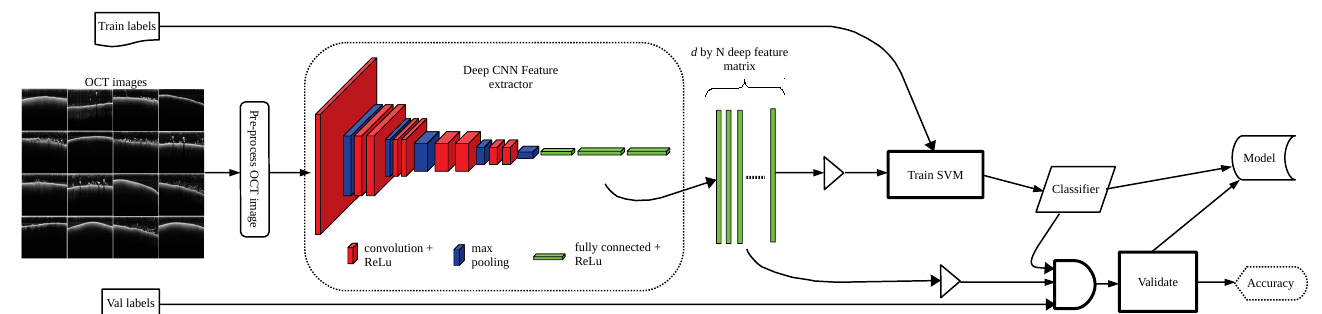
Figure 2. A pictorial description of the training algorithm used to train the ECOC-SVM model. The feature descriptor’s network layers are color-coded according to type. Red represents convolution layers, Blue represents Maximum pooling layers, and Green is for the fully connected layers.